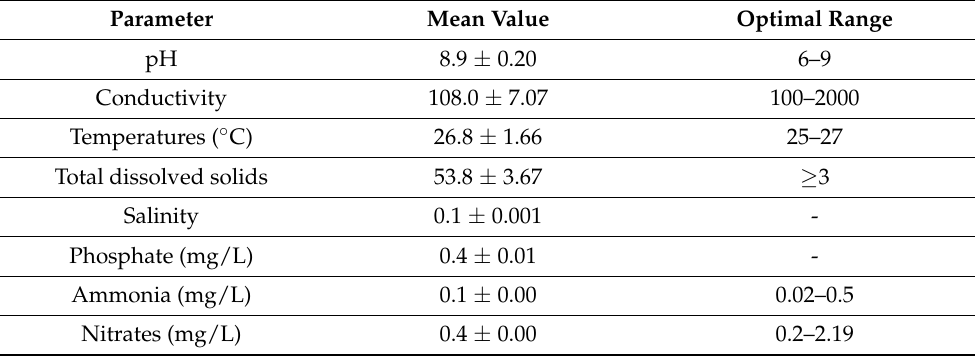
Table 2. Mean ( ± SE) pond water quality parameters during the rearing period of Nile tilapia .